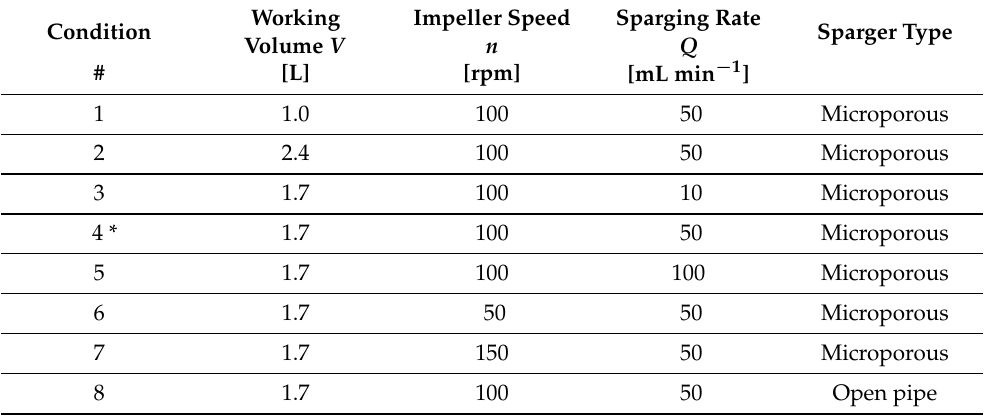
Table 1. Operating conditions, * denotes the base